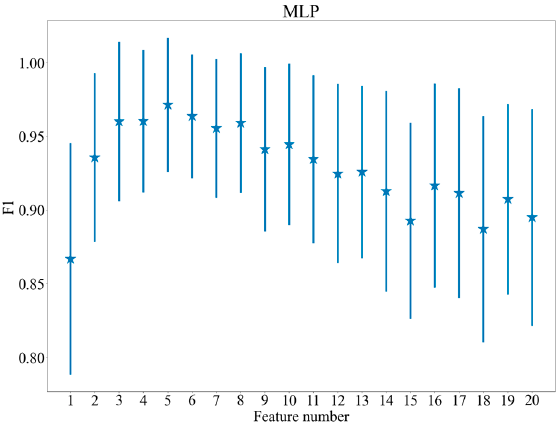
Figure 7. F1 scores for various feature numbers. Multilayer Perceptron (MLP). Table 5. Mean confusion matrix for SVM classifier with linear kernel.